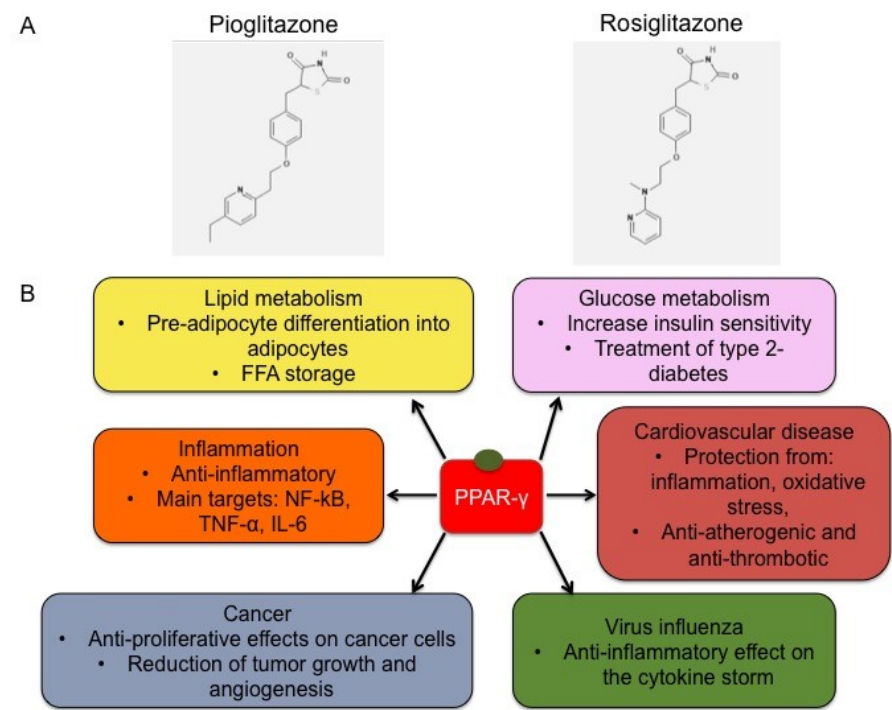
Figure 2. Chemical structure of representative TZDs and functions. ( A ) Chemical structure of pioglitazone (CID = 4829) and rosiglitazone (CID = 77999) [45]. ( B ) Schematic representation of TZD effects. The binding of TZDs, like pioglitazone and rosiglitazone, to PPAR- γ induces its activation, triggering the modulation of target gene expression and a broad range of mechanisms, including lipid metabolism, regulation of glucose levels, inflammatory processes, cell proliferation and migration, cardiovascular diseases and vascular remodeling, and cytokine storm occurrence under virus infections. Molecules 2020 , 25 , x